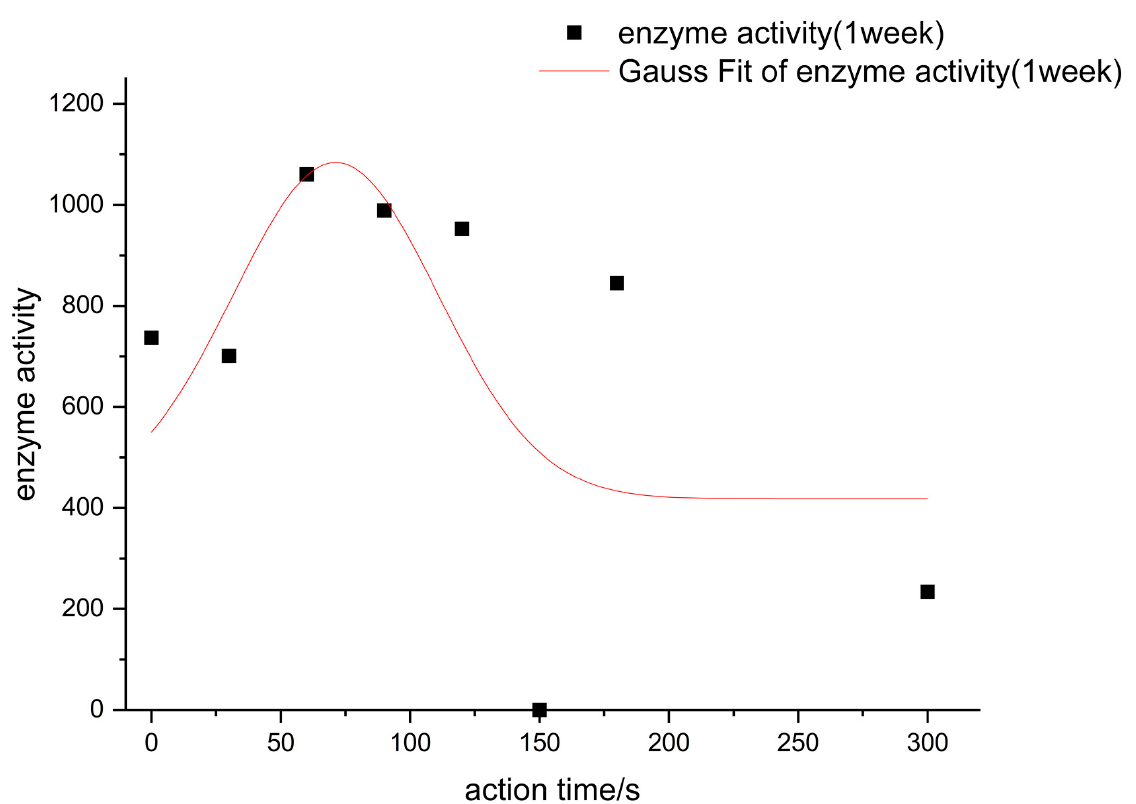
Figure 7. The diagram of low-pressure low-temperature α -amylase enzyme activity affected by plasma after 1 week.